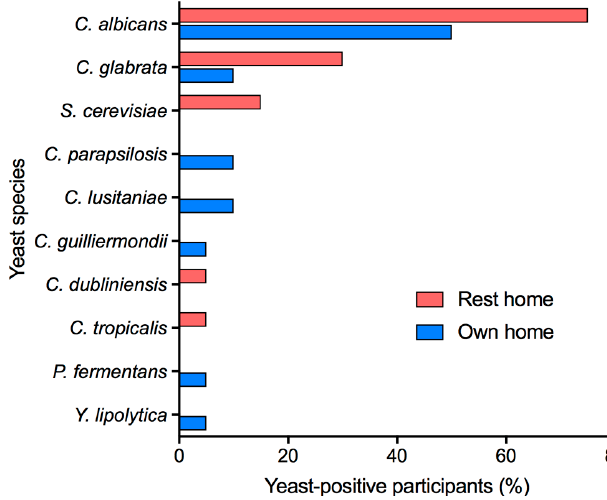
Figure 3. Species of yeast colonizing participants.